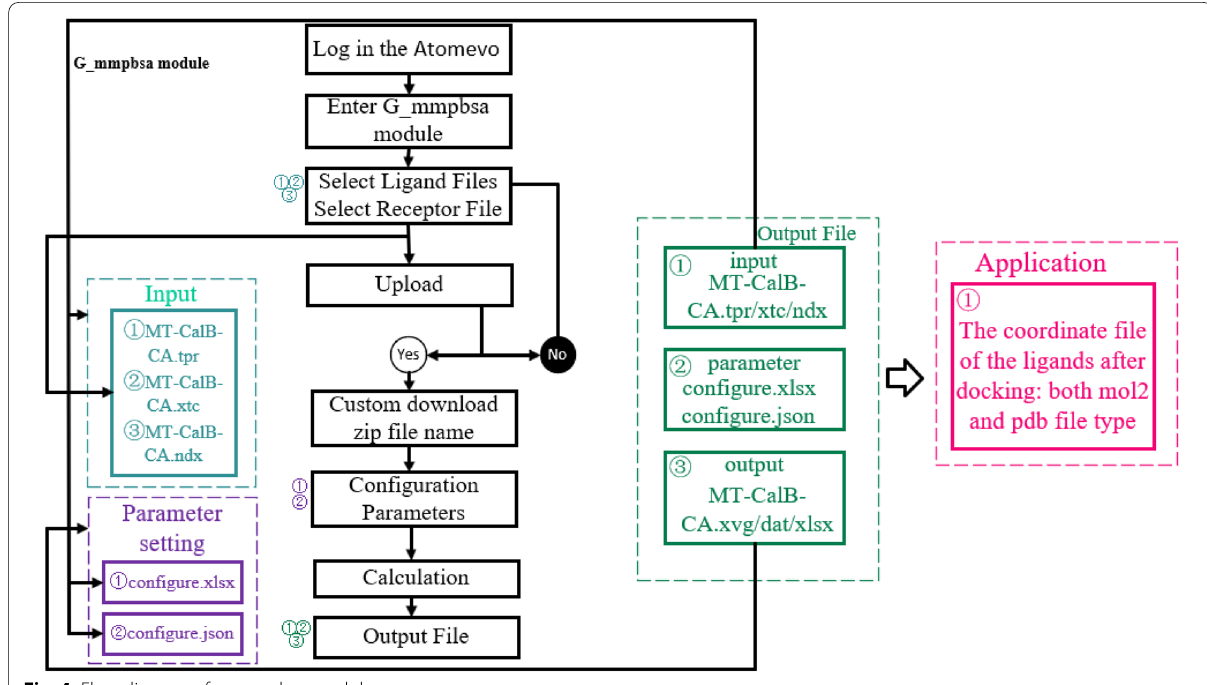
Fig. 4 Flow diagram of g_mmpbsa